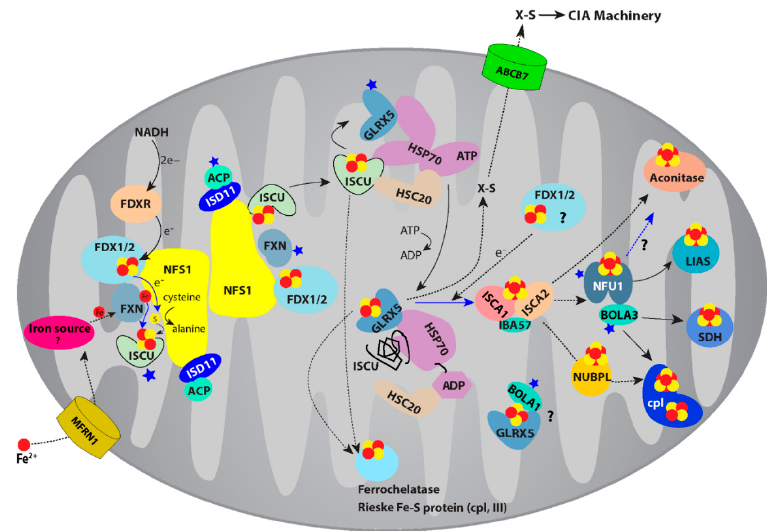
Figure 1. Schematic representation of the current model of human mitochondrial Fe-S cluster biogenesis. Iron enters the mitochondrion via the iron transporter MFRN1. The cysteine desulfurase NFS1 (N) exists in a dimeric form and mobilizes sulfur from L -cysteine for Fe-S cluster assembly. The accessory protein ISD11 (I) and acyl carrier protein ACP (A) are required for the function and stability of NFS1. The scaffold protein ISCU (U), frataxin FXN (F), and ferredoxin FDX2 (X) all bind to the surface of NFS1 to form the (NIAUXF) 2 complex. FXN is the proximal iron donor, which receives Fe 2+ from an unidentified iron source. FXN regulates the cysteine desulfurase activation of NFS1 and iron entry to ISCU. One electron to reduce S 0 to S 2 − is provided by an electron transport chain consisting of NAD(P)H, ferredoxin reductase (FDXR) and ferredoxin (FDX1/2). The other electron is likely provided by the oxidation of Fe 2+ bound to FXN. The assembled [2Fe-2S] cluster is transferred from ISCU to a monothiol glutaredoxin GLRX5 assisted by the dedicated chaperone–cochaperone (HSP70-HSC20) system. Subsequently, Fe-S clusters are either directly inserted into mitochondrial [2Fe-2S] proteins (e.g., Rieske protein), used for synthesis of a sulfur-containing species (X-S) for cytosolic Fe-S cluster assembly (CIA machinery). Assembly of [4Fe-4S] clusters involves ISCA1, ISCA2, and IBA57. An electron donor, such as ferredoxin, may be required to convert two [2Fe-2S] clusters to a [4Fe-4S] cluster. Late-acting factors, such as NFU1 and NUBPL, are required for the maturation of a subset of [4Fe-4S] clusters, such as LIAS and SDH. The mitochondrion export of the unidentified sulfur-containing compound (X-S) is facilitated by an ABC transporter ABCB7. In the cytoplasm, the cytosolic Fe-S cluster assembly machinery (CIA) inserts Fe-S clusters into cytosolic and nuclear Fe-S proteins. The blue stars denote the proteins (or the protein homologs) for which the structures were obtained by NMR, and blue arrows denote the processes that were clarified by NMR.